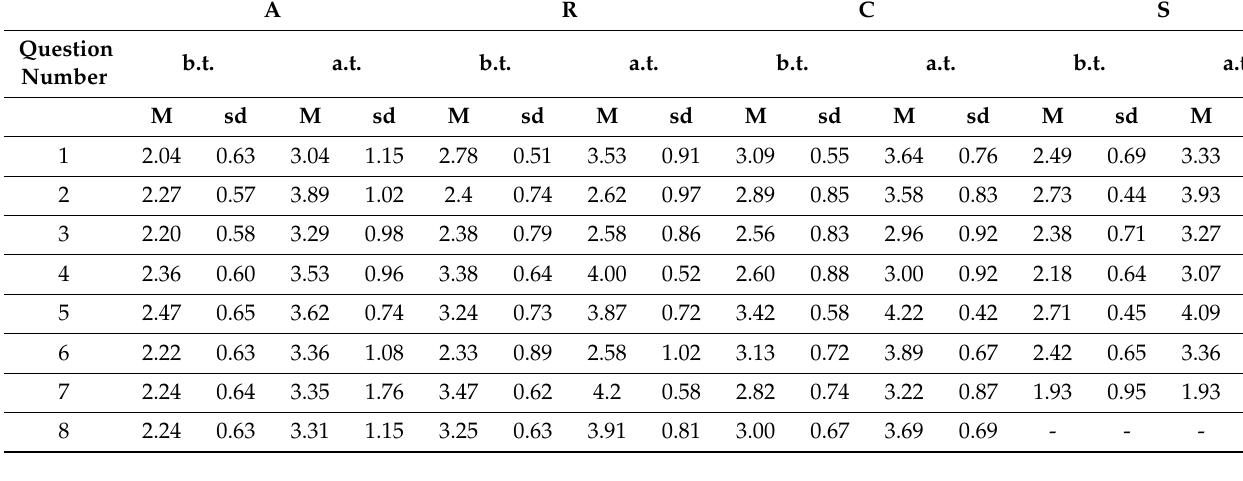
Table 3. Standard deviations of the participants’ answers per ARCS factor and per question of the ARCS model, before training (b.t.) and after training (a.t.).